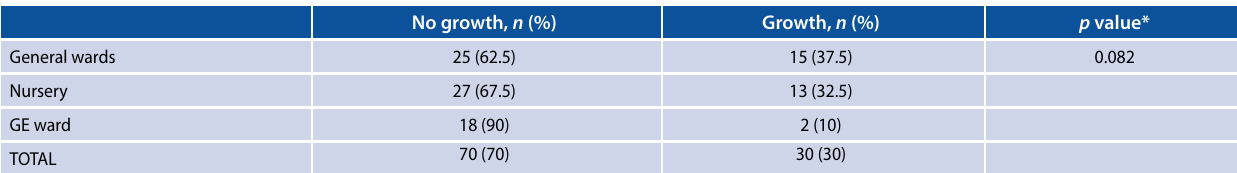
*Statistical analyses were performed using STATA version 11.1